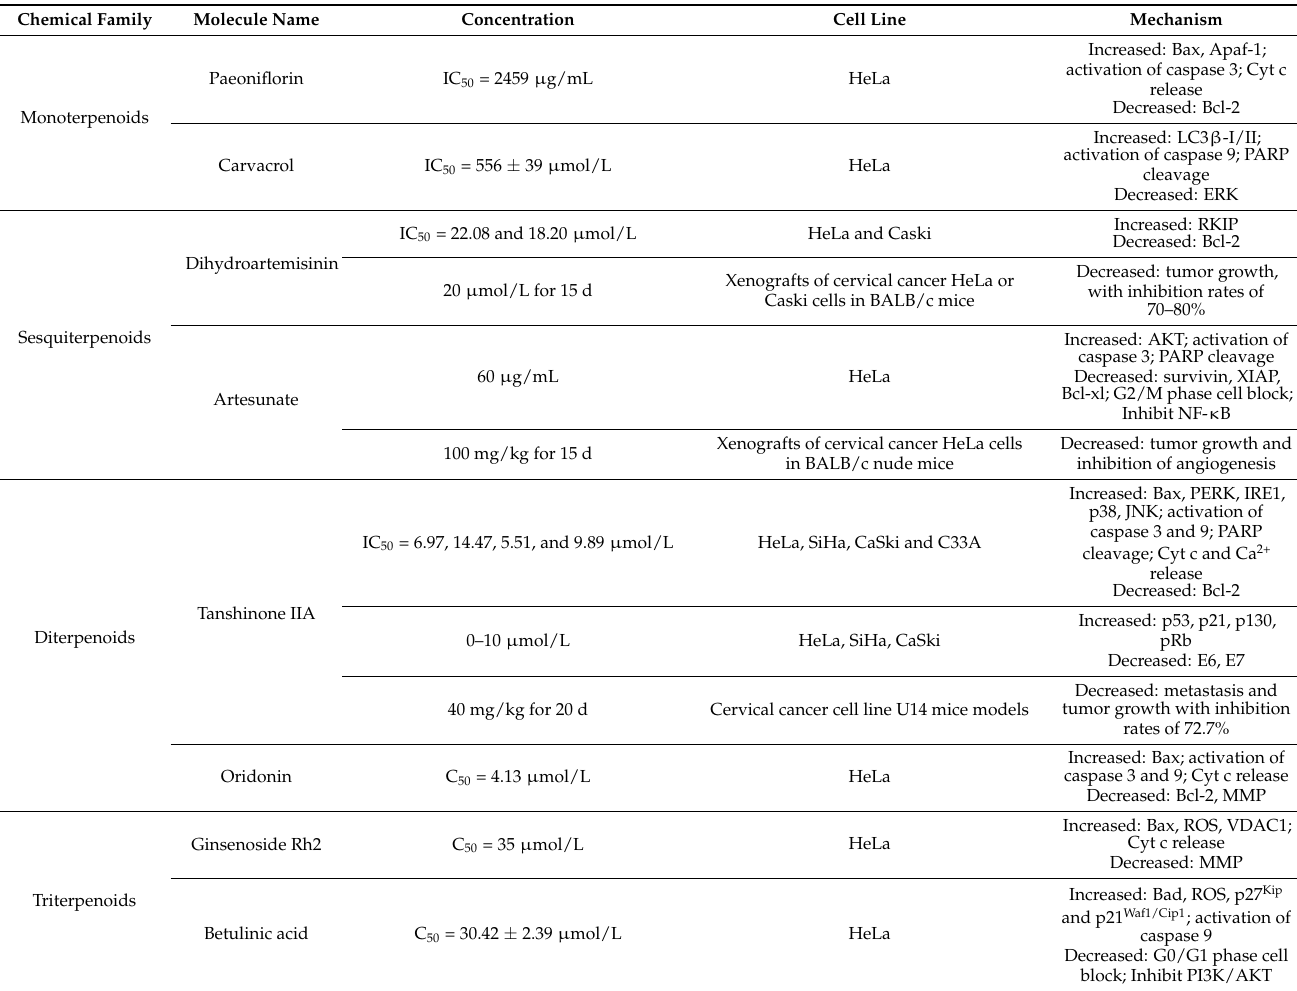
Figure 2. Chemical structure of several terpenoids in anti-cervical-cancer. Table 2. Effect of terpenoids on cervical